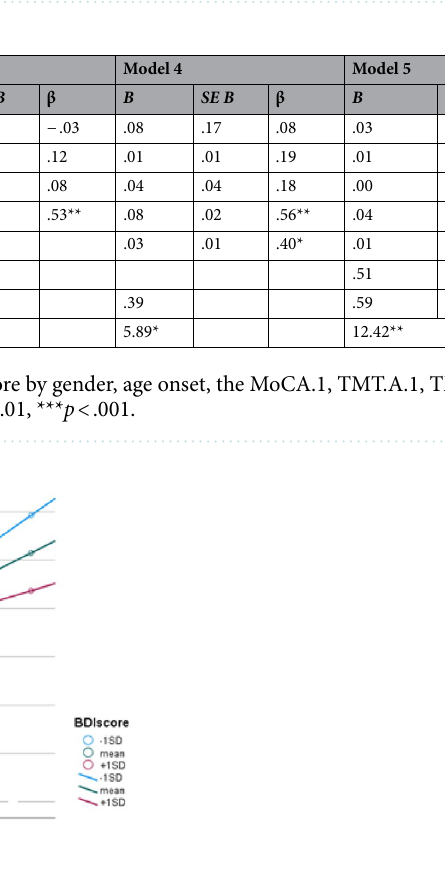
Table 4. Predicting the CFRS.2 score by gender and PD onset, the First MoCA.1, TMT.B.1, and BDI.1 scores and UPDRS-CF.1 Feature. *** p < .001.